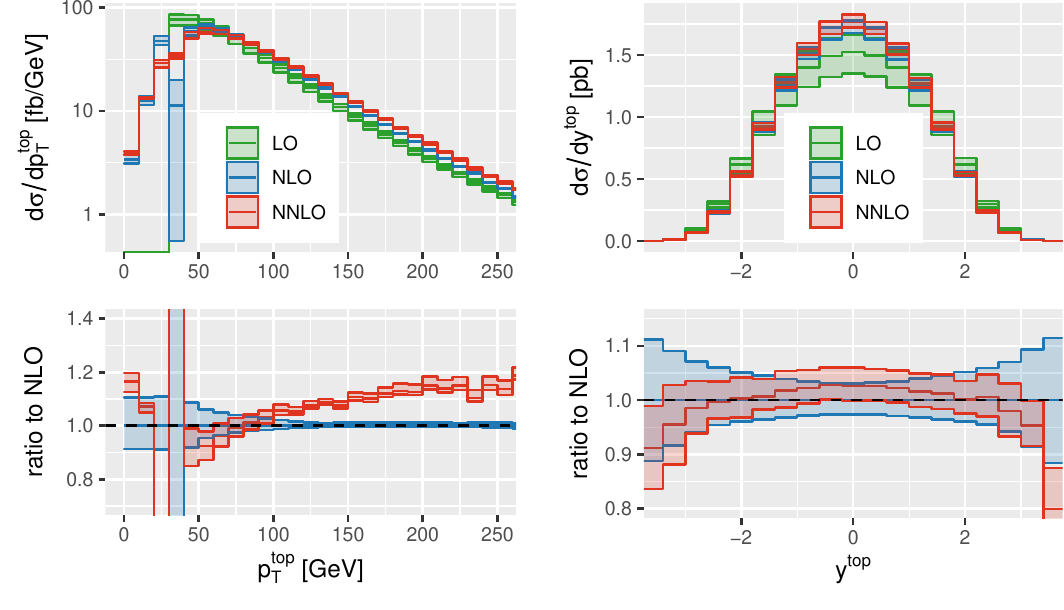
Figure 11 . Top-quark transverse momentum distribution (left) and rapidity distribution